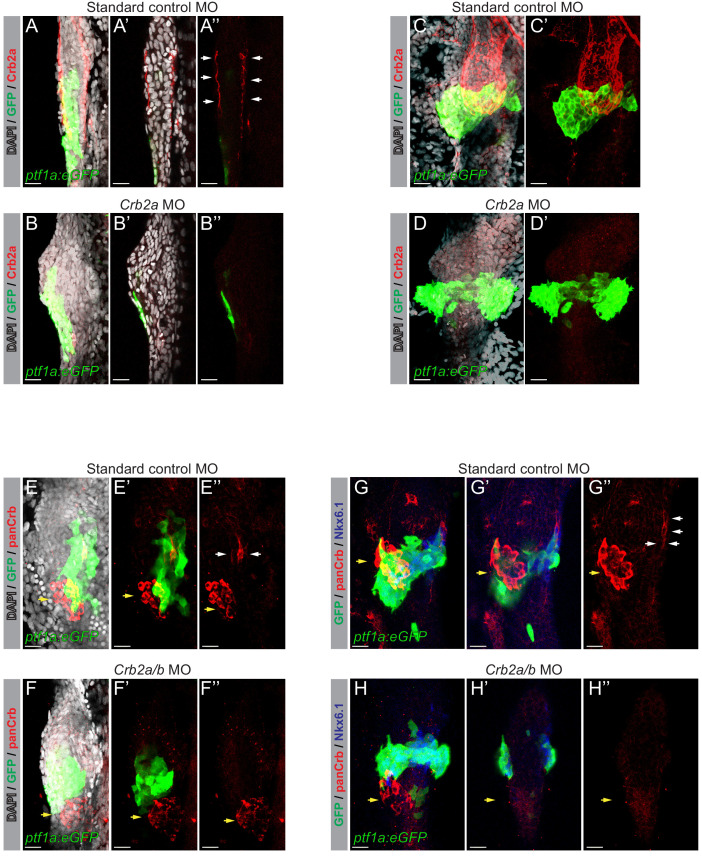
Validation of morpholinos targeting crb2a and crb2b.(A,B) 3D renderings of 32–34 hpf Tg(ptf1a:eGFP)jh1 zebrafish foregut endoderm labeled with DAPI (nuclei, grey) and anti-Crb2a antibodies (red). (A–A’’) Z-focal plane image showing Crb2a labeled (red) foregut endoderm from embryos injected with standard control morpholinos (n = 6). (B–B’’) Z-focal plane image showing loss of Crb2a staining (red) in the foregut endoderm from embryos injected with morpholinos targeting crb2a (n = 6/6). (C,D) 3D renderings of 45 hpf Tg(ptf1a:eGFP)jh1 zebrafish foregut endoderm labeled with DAPI (nuclei, grey) and anti-Crb2a antibodies (red). (C–C’) Z-focal plane image showing Crb2a-labeled (red) embryos injected with standard control morpholinos (n = 3). (D–D’) Z-focal plane image showing loss of Crb2a staining (red) in embryos injected with morpholinos targeting crb2a (n = 3/3).(E,F) 3D renderings of 32–34 hpf Tg(ptf1a:eGFP)jh1 zebrafish foregut endoderm labeled with DAPI (nuclei, grey) and anti-panCrb antibodies (red). (E–E’’) Z-focal plane image showing pancreatic progenitors marked by ptf1a:eGFP (green) and labeled with anti-panCrb antibodies (red; white arrows) from embryos injected with standard control morpholinos (n = 8). (F–F’’) Z-focal plane image showing reduced panCrb (red) staining in pancreatic progenitors marked by ptf1a:eGFP (green) from embryos injected with morpholinos targeting both crb2a and crb2b (n = 4/5). (G,H) 3D renderings of 45 hpf Tg(ptf1a:eGFP)jh1 zebrafish foregut endoderm labeled with anti-Nkx6.1 (blue) and anti-panCrb (red) antibodies. (G–G’’) Z-focal plane image showing pancreatic progenitors marked by ptf1a:eGFP (green) and labeled with anti-Nkx6.1 (blue) and anti-panCrb (red; white arrows) antibodies from embryos injected with standard control morpholinos (n = 4). (H–H’’) Z-focal plane image showing reduced panCrb (red) staining in pancreatic progenitors marked by ptf1a:eGFP and labeled with anti-Nkx6.1 antibodies (blue) from embryos injected with morpholinos targeting both crb2a and crb2b (n = 3/4). Yellow arrows denote dorsal pancreas where panCrb labeling remains in control injected embryos, possibly due to expression of alternate Crb proteins present within the dorsal pancreas. Scale bar, 20 µM. MO, morpholino.